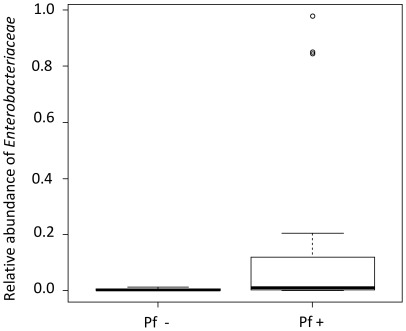
Relative abundance of Enterobacteriaceae in P. falciparum non-infected (Pf−) or P. falciparum infected (Pf+) mosquitoes.The Enterobacteriaceae loads are significantly higher in P. falciparum infected mosquitoes (P = 0.004; Mann–Whitney test). The boxes represent the interquartile range (25–75th percentile), and the line within each box corresponds to the median value.